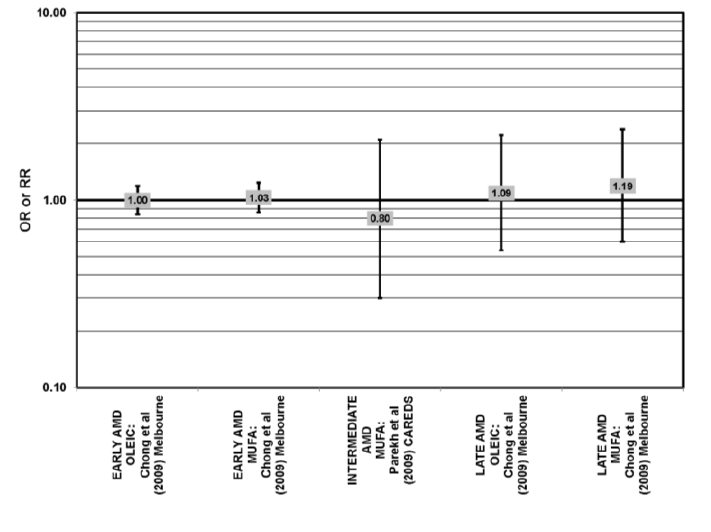
Figure 18. Odds or risk ratio for early AMD, intermediate AMD or late AMD; high vs. low intake of monounsaturated fatty acids: prospective